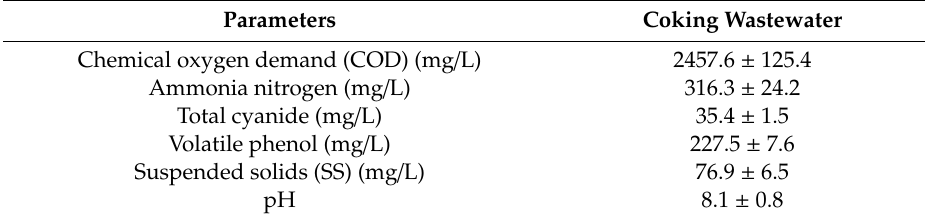
Table 2. Characteristics of coking